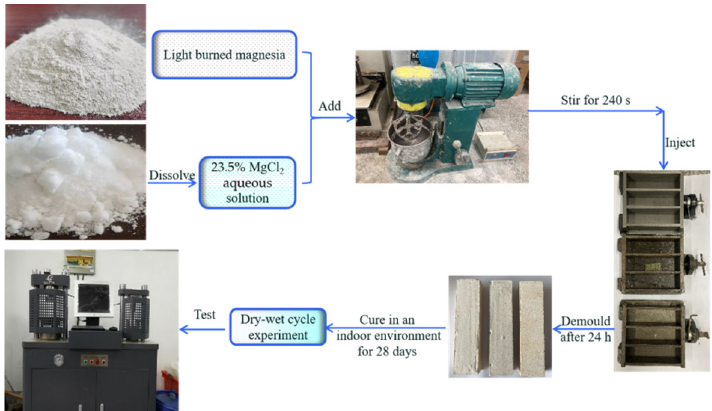
Figure 1. Flowchart showing the fabrication process of the MOC samples.